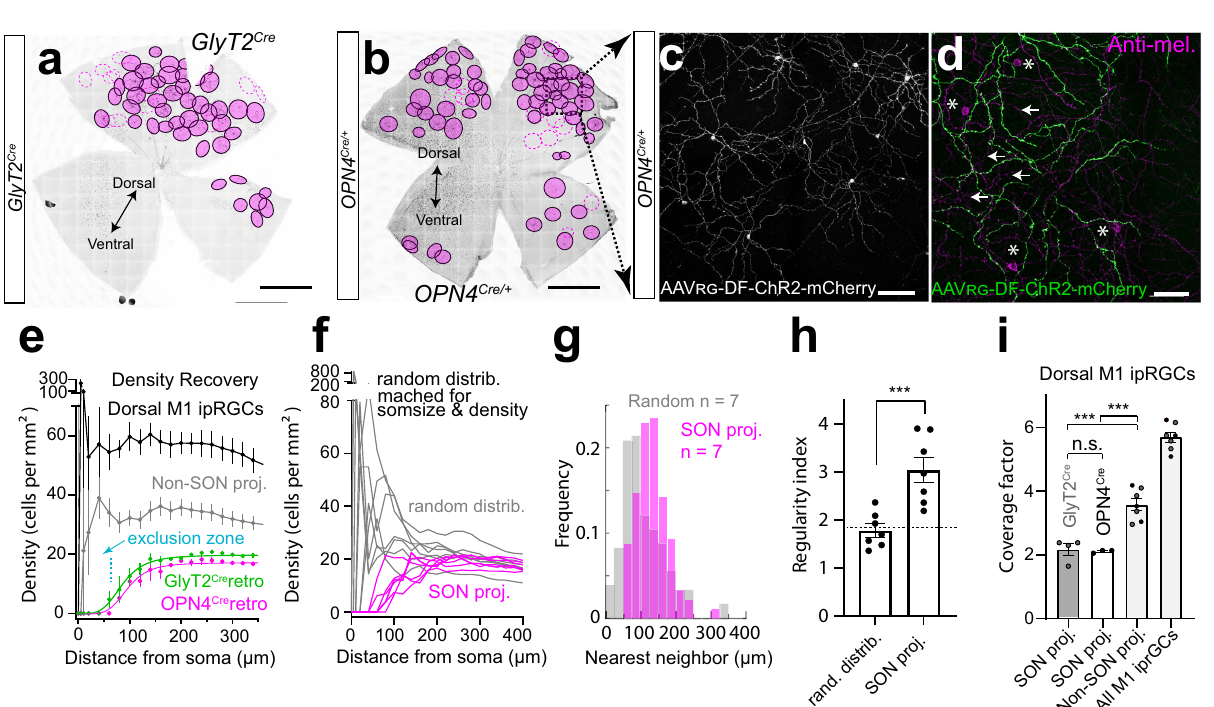
Fig. 6 | GlyT2 Cre ipRGCs form the principle projection to the SON. a , b Stereotactic injections of Cre -dependent retroAAV into the SON labels a population of ipRGCs. c Confocal micrograph (left) and side z-projections (right) illustrate that retro-labeled cells are M1 ipRGCs; with dendrites that stratify in sublamina-a of the inner plexiform layer (IPL). Arrows indicate axons in the gang- lion cell layer (GCL) INL=inner nuclear layer. d Distribution maps of retro-labeled ipRGCs in GlyT2 Cre and e OPN4 Cre mouse lines. The density at each retinal location along the dorso-ventral axis is plotted on the right. f Confocal micrograph illus- trates dorsal retro-labeled SON-projecting M1 ipRGCs (asterisks) in the OPN4 Cre mouseandasingleventralaxon(arrows). g BargraphsofipRGCsperretinathatare melanopsin-positive or negative (left; error bars±SEM p =0.2633) and M1 ipRGCs or non-M1 ipRGCs in SON-injected GlyT2 Cre and OPN4 Cre mice retinas labeled with SONinjectionsofretroAAV(datawerepresentedasmeanvalues±SEM; n =3retina